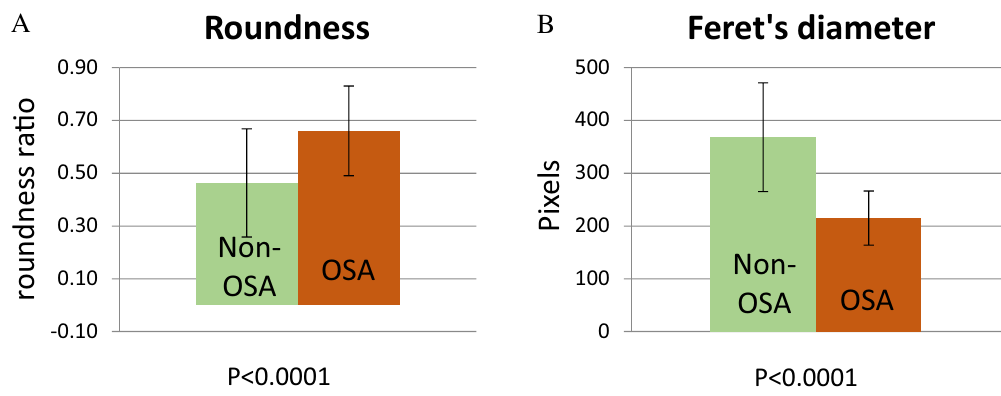
Figure 6. Quantification of morphologic parameters of immortalized human CM cells as analyzed from H&E staining: ( A ) Roundness, ( B ) Feret’s diameter (cell’s elongation). A value of 1.0 in the parameter of roundness indicates a perfect circle (see C.2.6). Feret’s diameter refers to the longest straight line in a certain shape, and represents the degree of elongation of a cell.CM exposed to OSA demonstrated shortening of Feret’s diameter and rounding of the cells (P < 0. 0.0001 in both).